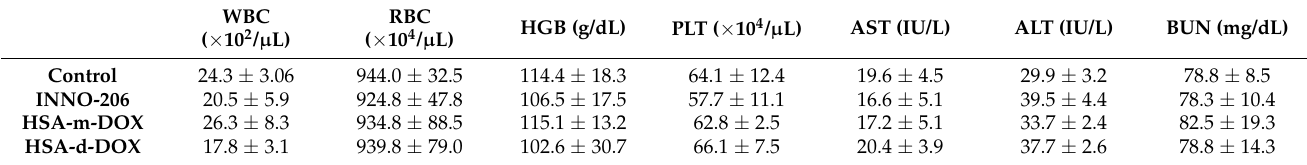
Parameters of blood cells (white blood cell (WBC) count, red blood cell (RBC) count, hemoglobin (HGB) count, platelet (PLT) count), aspartate transaminase (AST), alanine aminotransferase (ALT), blood urea nitrogen (BUN) in C26 ectopic tumor bearing mice at day 28. Data are averages ± standard deviation. ( n =